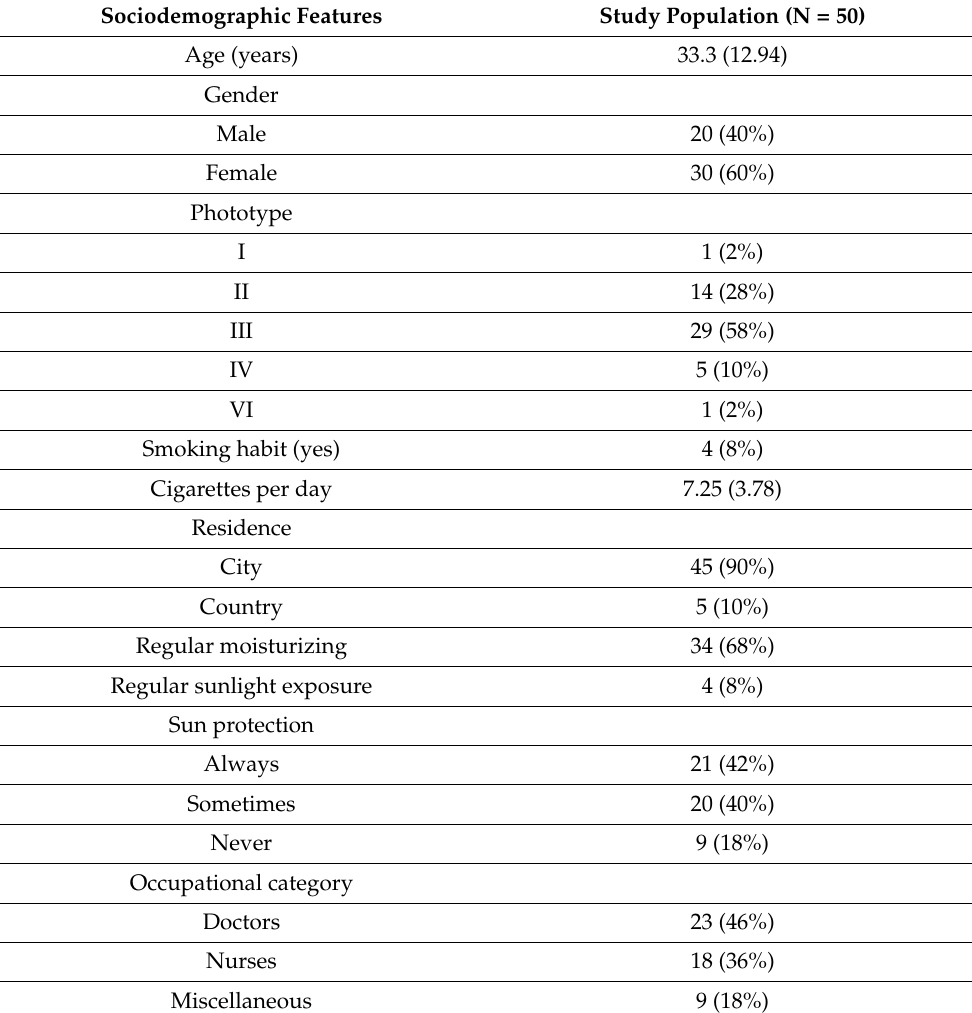
Table 1. Descriptive characteristics of the